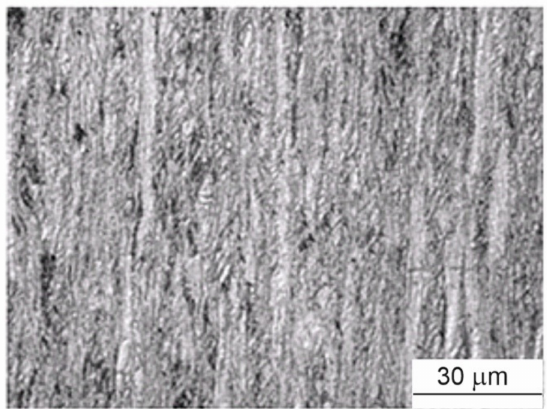
Figure 17. Optical microstructure of cold-rolled Cu-13.5 wt%Sn alloy